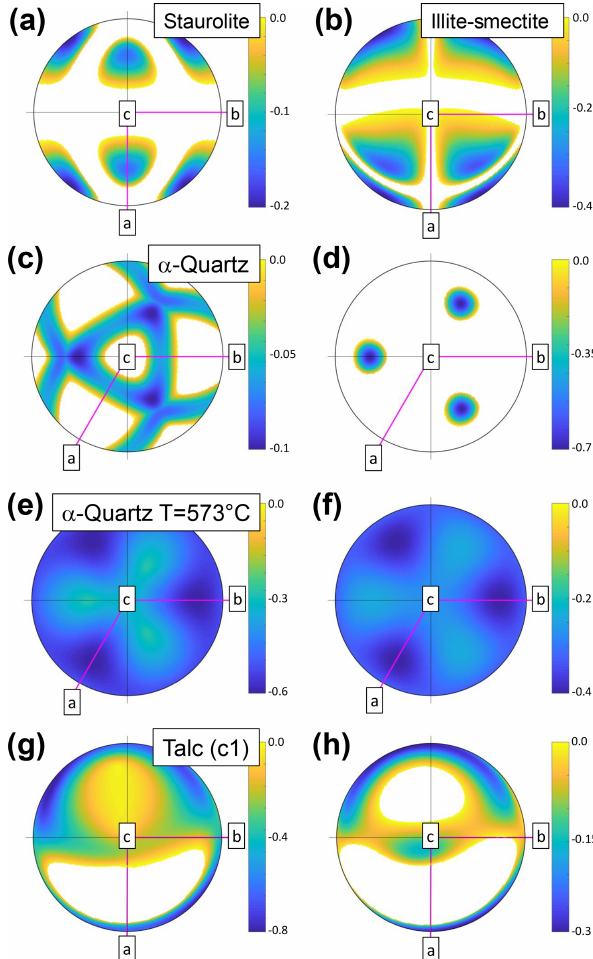
Figure 13. Examples of rock-forming minerals showing auxetic and areally auxetic behaviours. Stereograms are all lower-hemisphere equal-area projections and only the directions with negative Pois- son’s ratio (a, b, c, e, g) or negative areal Poisson’s ratio (d, f, h) are shown coloured in (i.e. other directions show positive